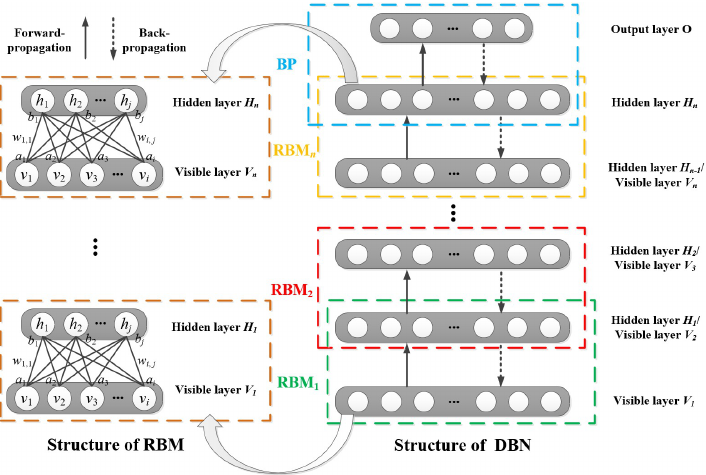
Figure 2. DBN network model structure of n stacked